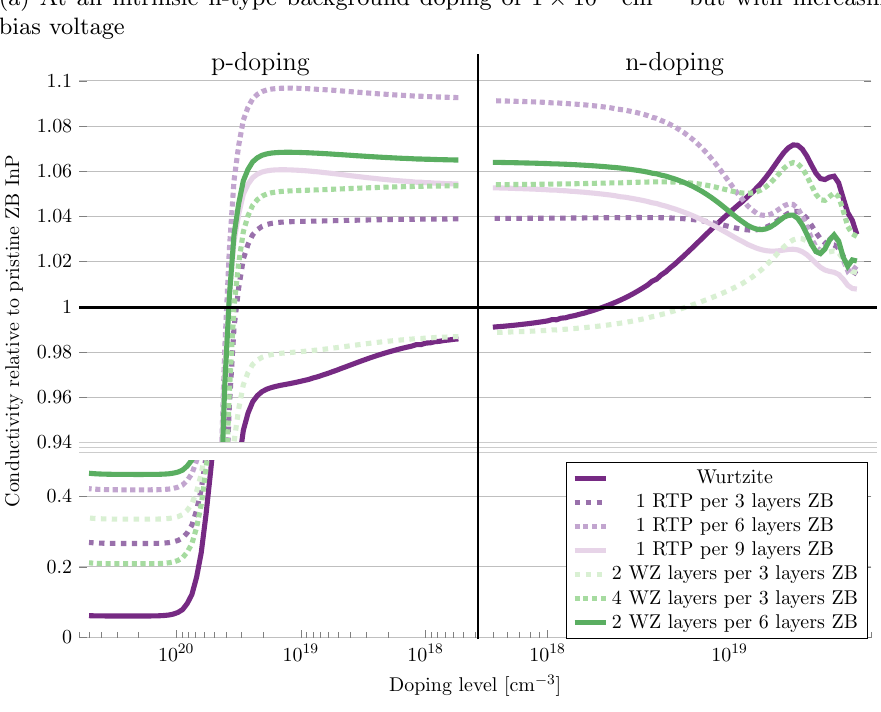
(b) At zero bias voltage but with various doping levels of either type from small to high doping levels. Figure 8. Differential conductivity of InP phase-defect systems along the [11 direction, relative to a pristine ZB